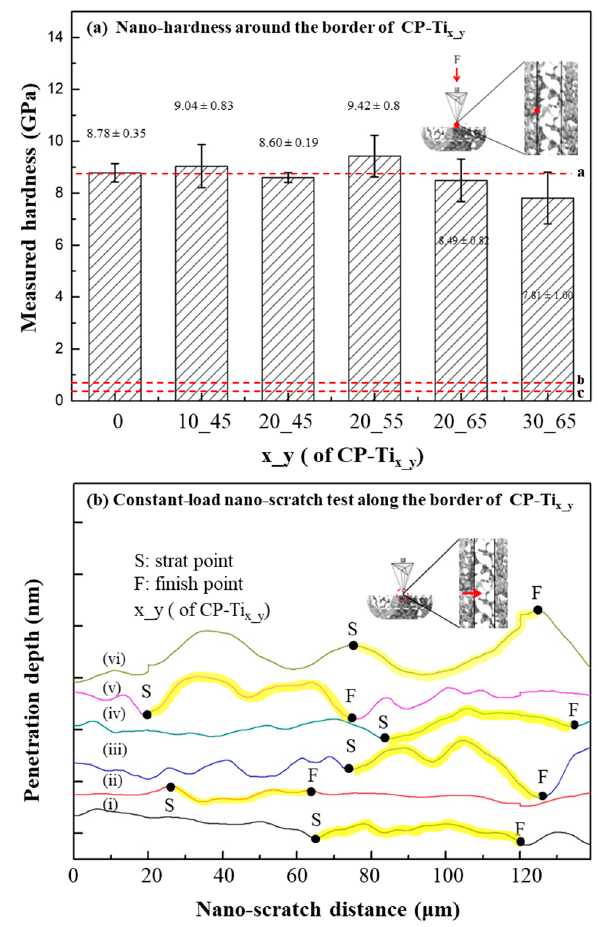
Figure 5. ( a ) Nano-hardness tests around the border (i.e., one of the dotted lines as shown in Figure 2) of dual porous structures. ( b ) Constant-load nano-scratch test along the border (i.e., crossing over the dotted line with the direction from regions x to y). The scratch distances were marked from the starting point S and the final point F. In general, under a constant load mode, no significant change in the penetration depth was found. As a result, a continuous dual porous structure was obtained.